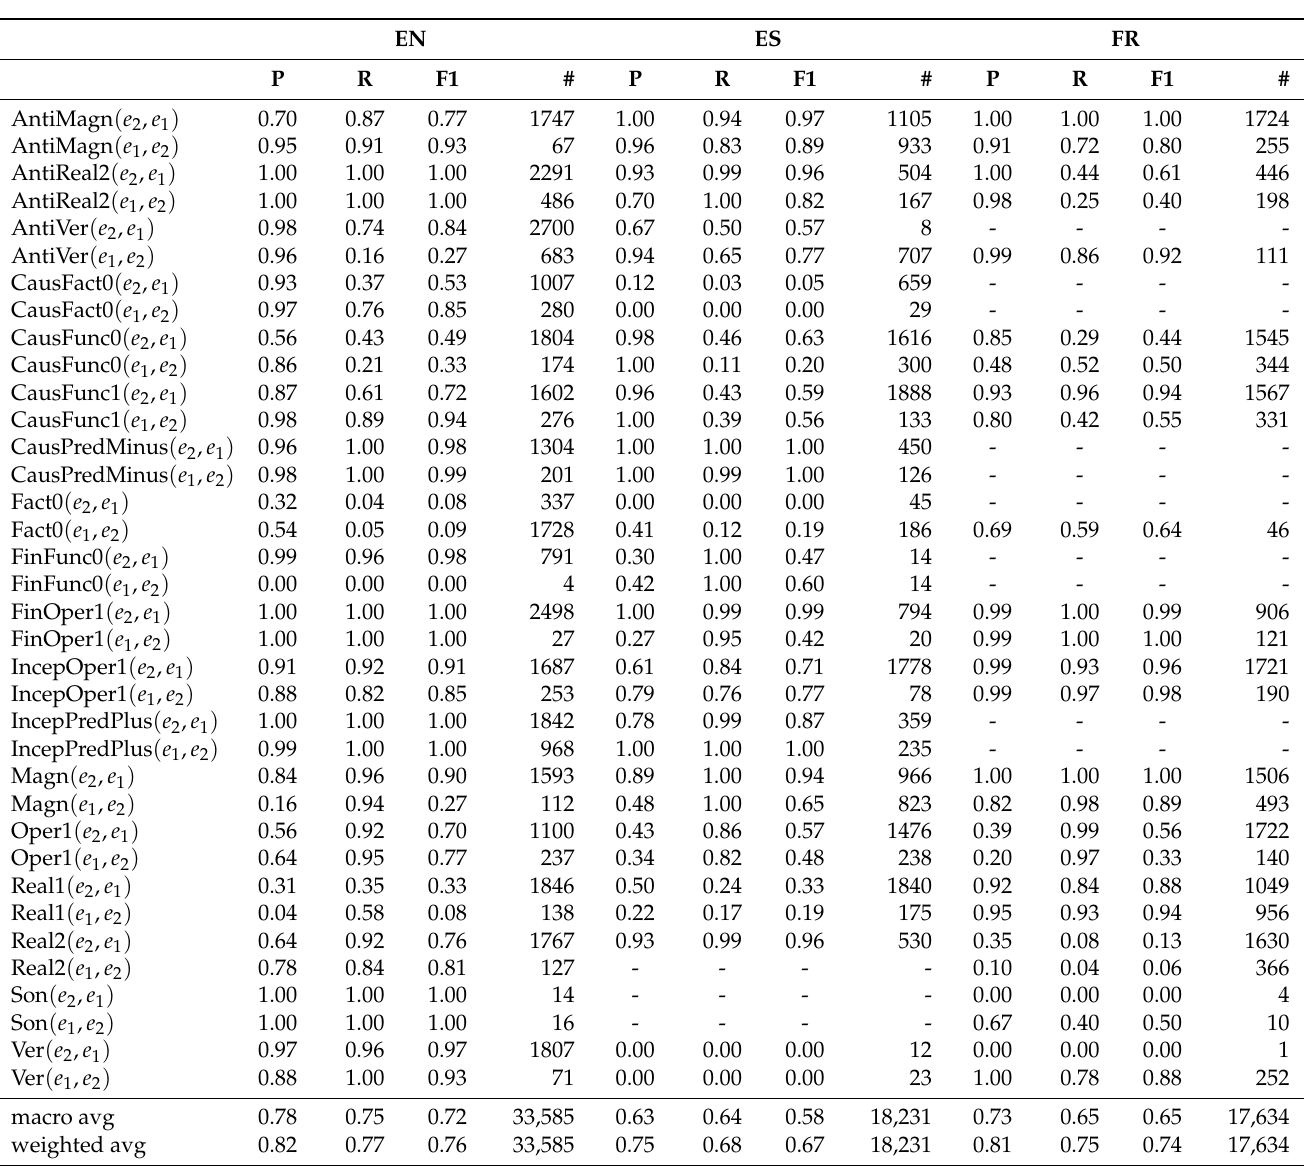
Table 5. Results breakdown per LF on the test set, where, for each LF, we list individual results for different order of bases and collocates in a sentence.